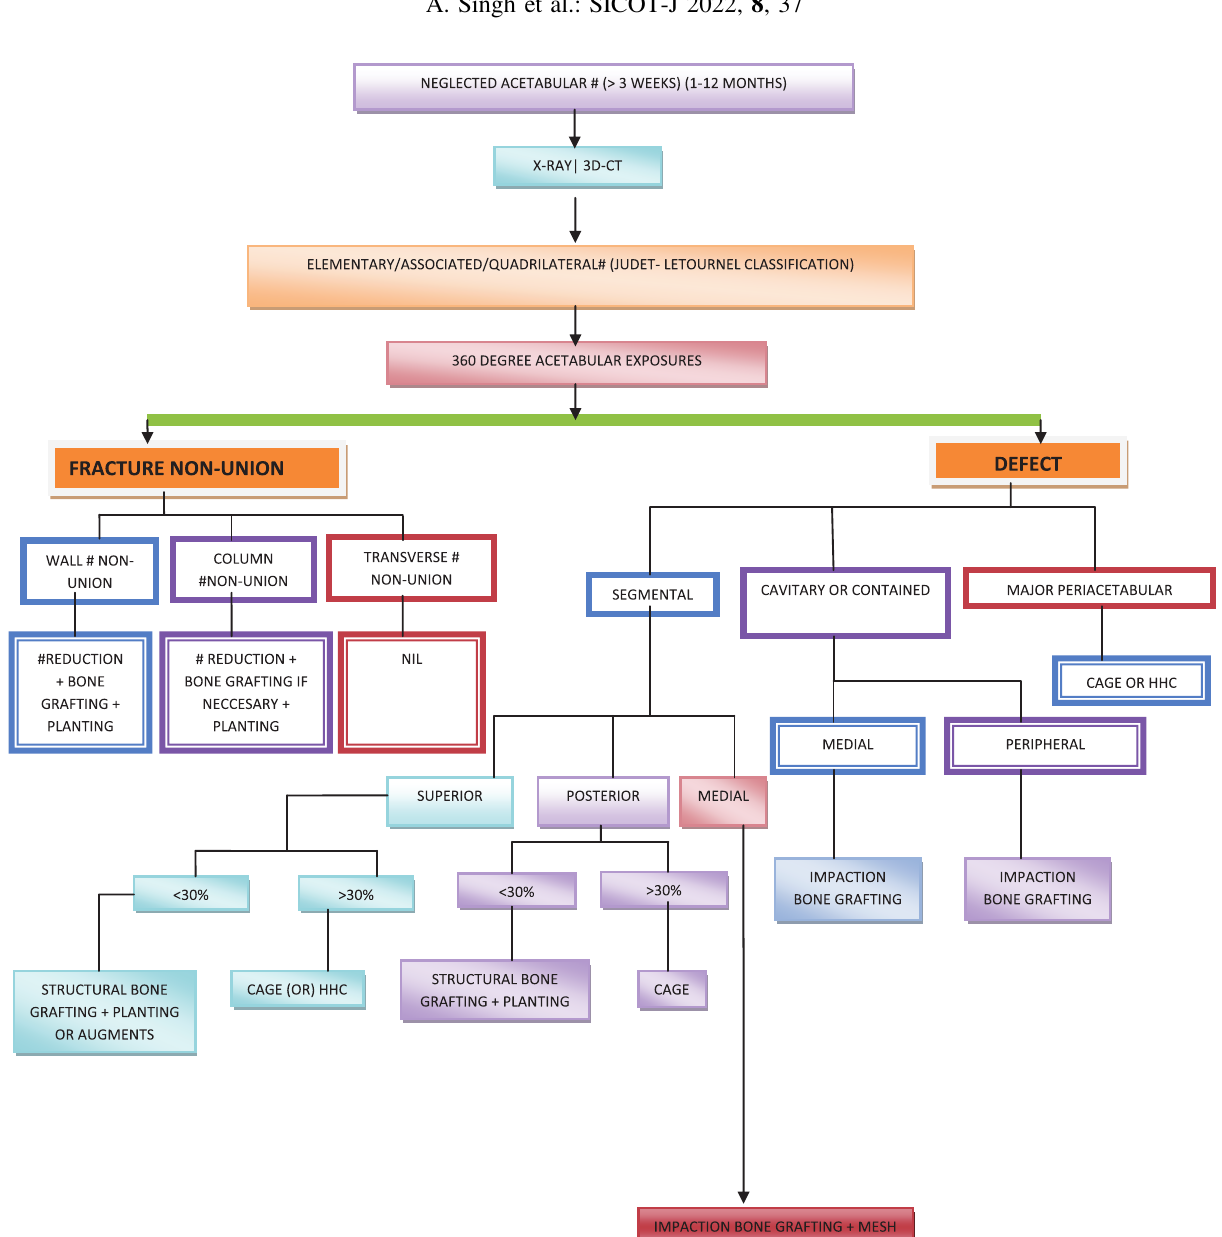
Figure 2. Overview of management of neglected acetabular fracture at our institute.